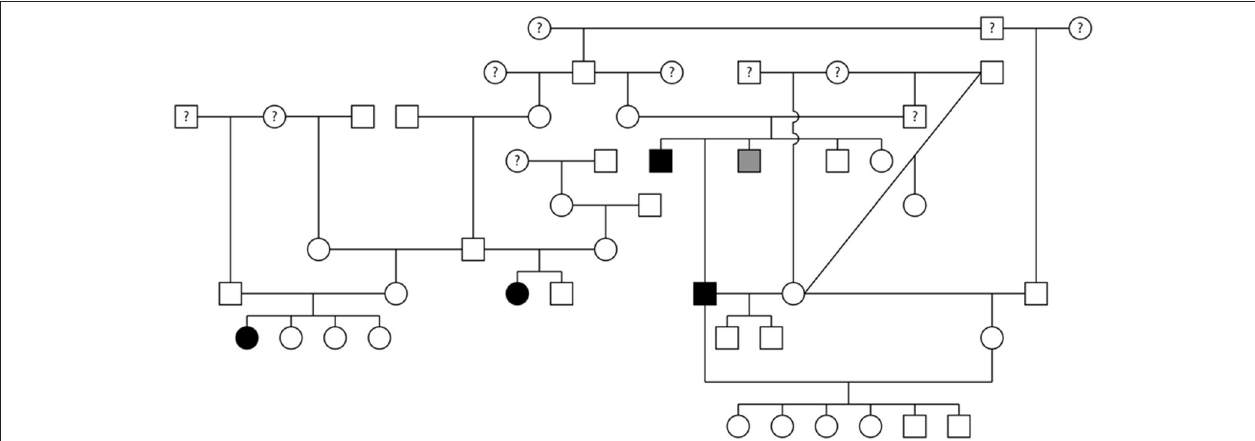
FIGURE 5 | Pedigree representing an extended family of 48 Rottweilers phenotyped for subvalvular aortic stenosis (SAS). Affection status is represented as follows: squares represent males, circles represent females, open symbols are SAS unaffected, gray symbols are SAS equivocal, black symbols are SAS affected, and symbols with questions marks have unknown SAS cardiac status.